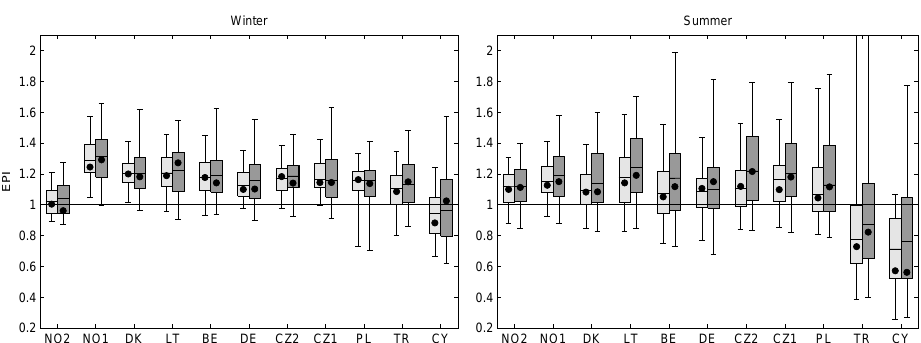
Figure 2. EPI estimated from the comparison of the downscaled time series for control and future period for 1-year (light grey boxes) and 5-year levels (dark grey boxes). The boxes indicate the 25, 50, and 75th percentiles and the whiskers the 5 and 95th percentiles. The circles show the median of all the values of EPI estimated from the comparison of the RCM outputs for the control and future periods. All the results are for a temporal aggregation of 1